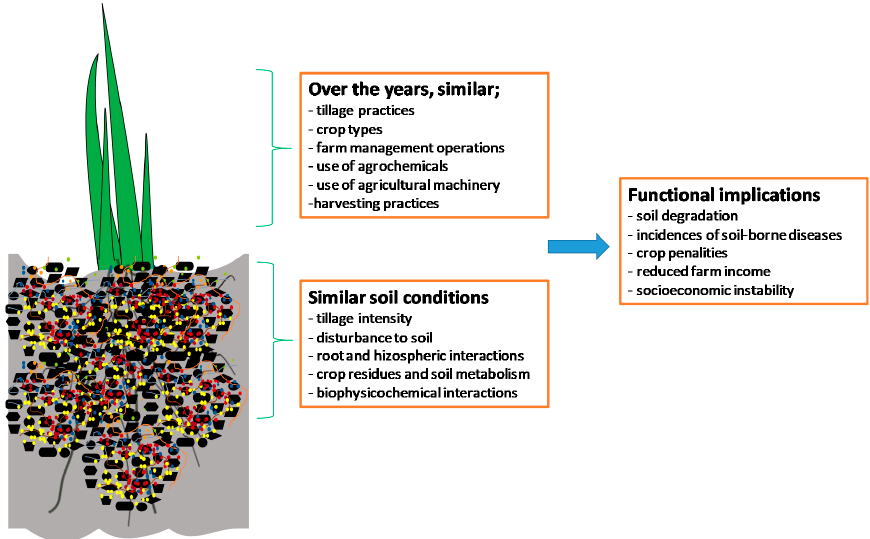
Figure 1. Predicted hypothetical impact of continuous cropping (CC) on soil health.